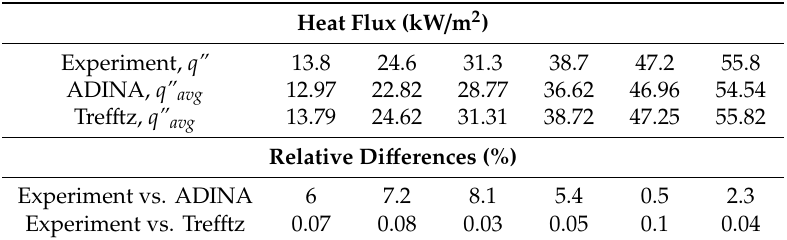
Table 4. The heat flux calculated on the basis of experimental measurements and determined from the 2D approach calculations (average) and relative di ff erences between them, the data for the test section with five minichannels.